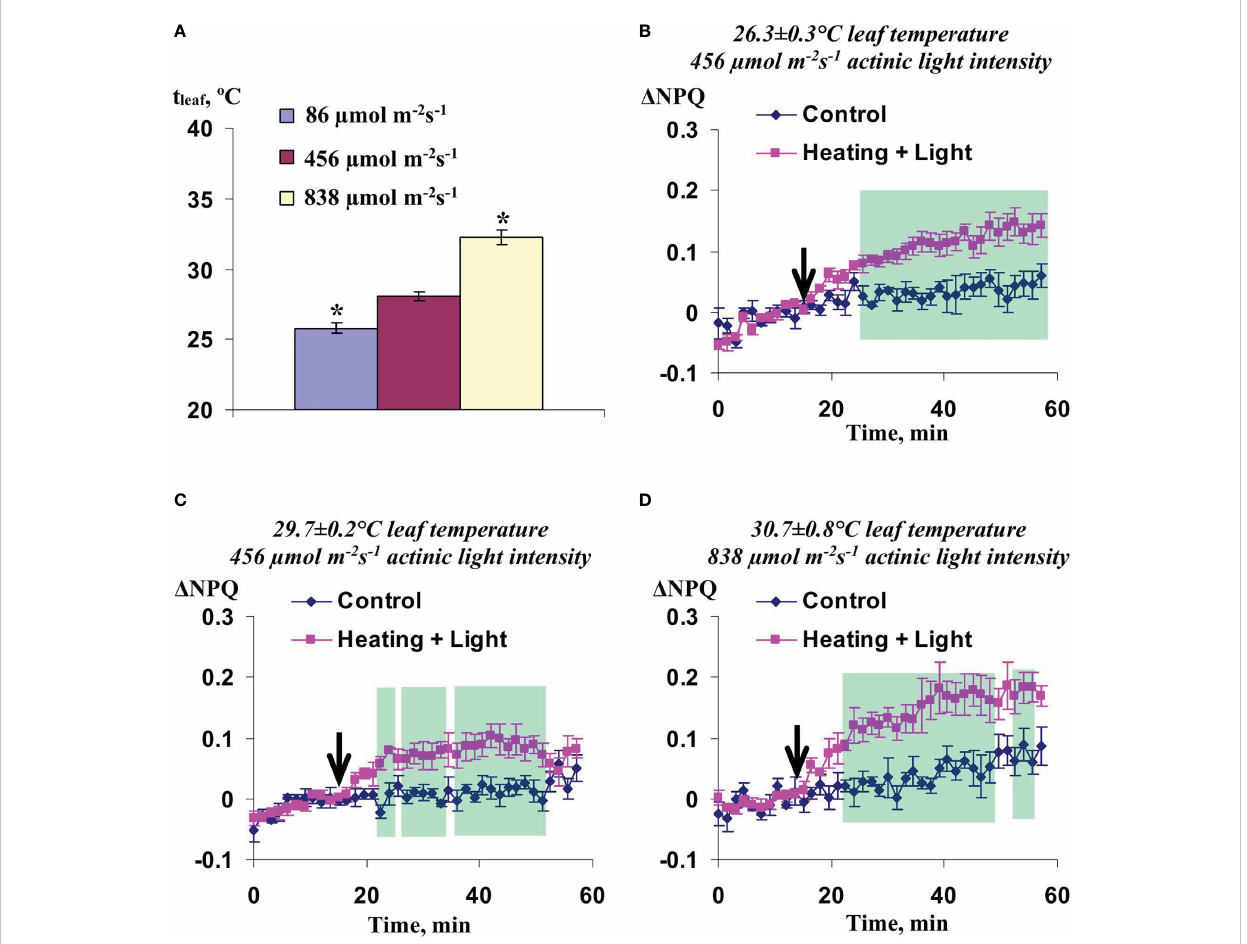
FIGURE 5 Leaf temperatures (t leaf ) under different intensities of the actinic light ( n =16-24) (A) and averaged changes in the non-photochemical quenching of chlorophyll ( D NPQ) in 3 cm from zone of the local action of combination of heating and blue light in wheat plants under the 26.3 ± 0.3°C leaf temperature and 456 µmol m -2 s -1 actinic light intensity ( n =4) (B) , under the 29.7 ± 0.2°C leaf temperature and 456 µmol m -2 s -1 actinic light intensity ( n =4) (C) , and under the 30.7 ± 0.8°C leaf temperature and 838 µmol m -2 s -1 actinic light intensity ( n =4) (D) . Leaf temperatures were measured in 3 cm from the irritated zone before the local action of heating and blue light with using the Testo 885 thermal imager. Statistical analysis providing these D NPQ was described in the Section 3.1. Green shadings show time intervals with signi fi cant differences between experimental and control values ( p <0.05, Student ’ s test). *, the leaf temperature was signi fi cantly differed from the temperature under 456 µmol m -2 s -1 actinic light